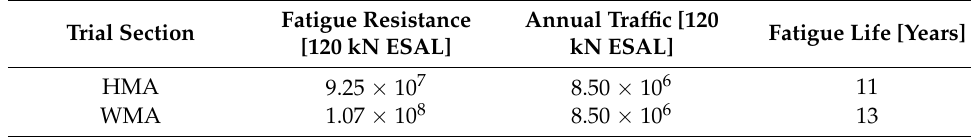
Table 3. Outcomes of the KENPAVE simulations.